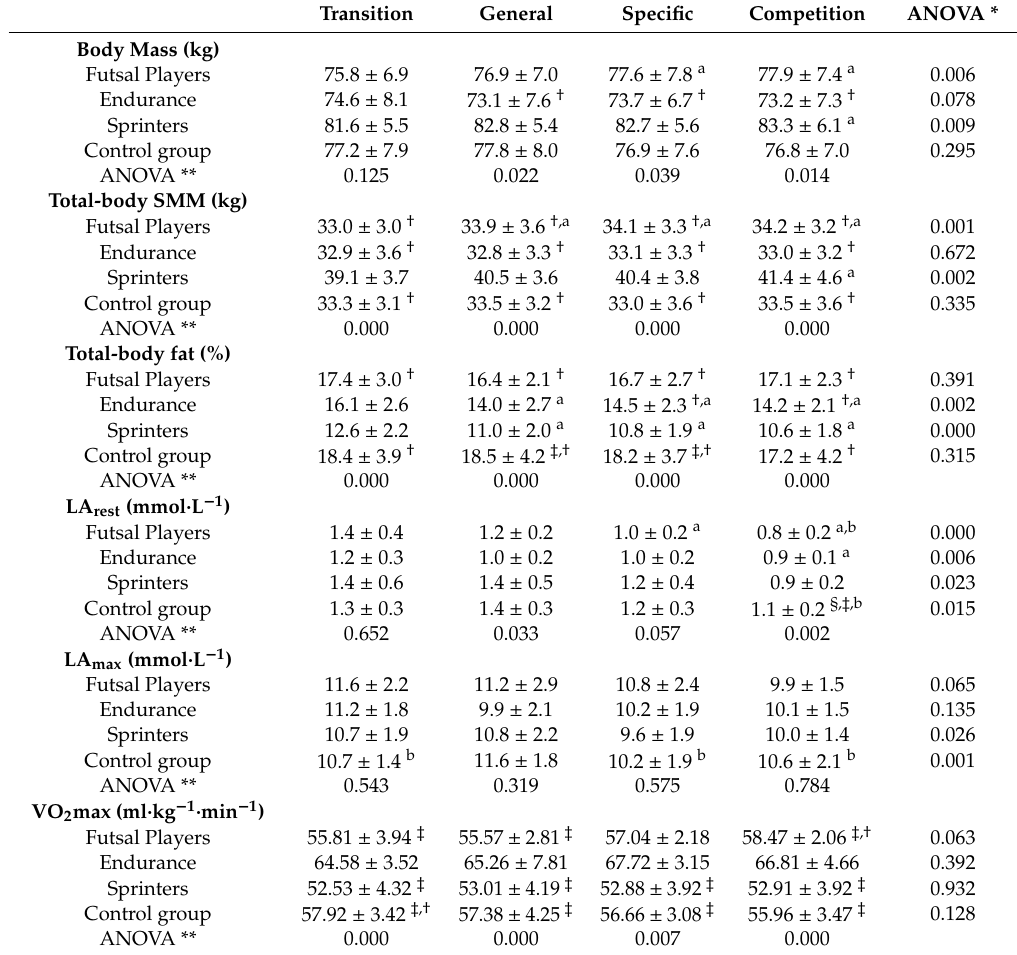
Table 2. Descriptive and exercise characteristics in four consecutive training phases in futsal players ( n = 11), endurance athletes ( n = 11), sprinters ( n = 11), and control group ( n =